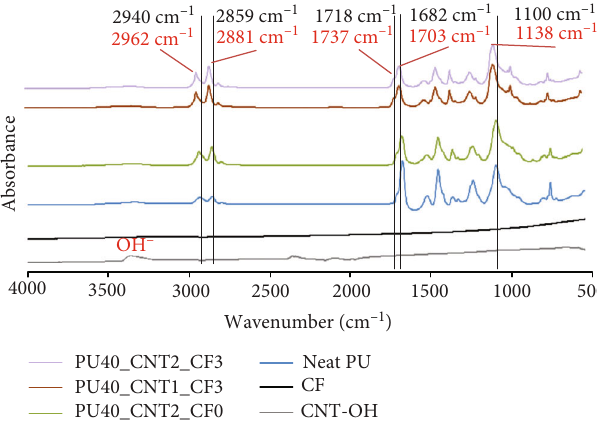
Figure 6: FTIR spectra of neat PU, carbon components, and nanocomposites modi fi ed with CNT-OH and CF.